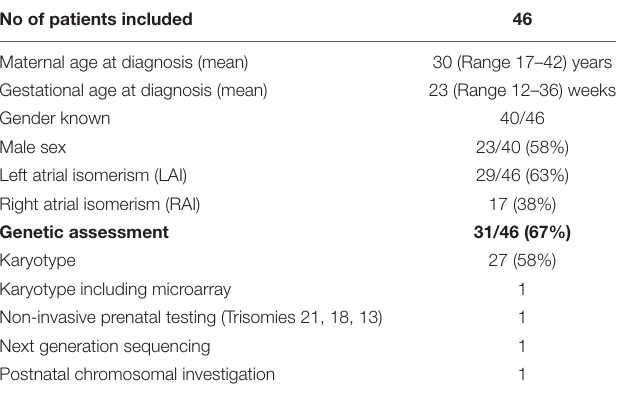
TABLE 1 | Clinical characteristics of the study